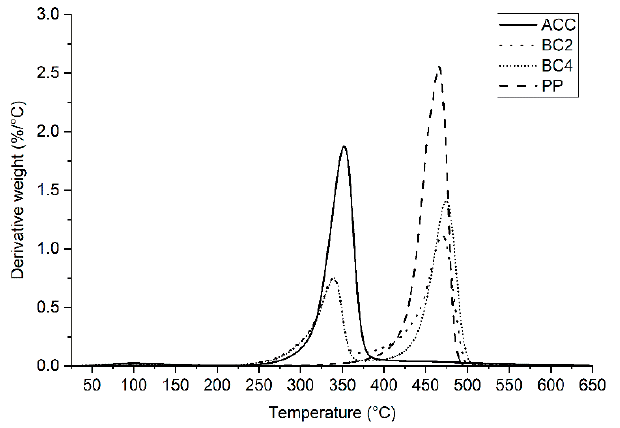
Figure 6. Results of the DTGA for all-cellulose composites (ACC), biocomposites (BC2 and BC4) and polypropylene (PP).